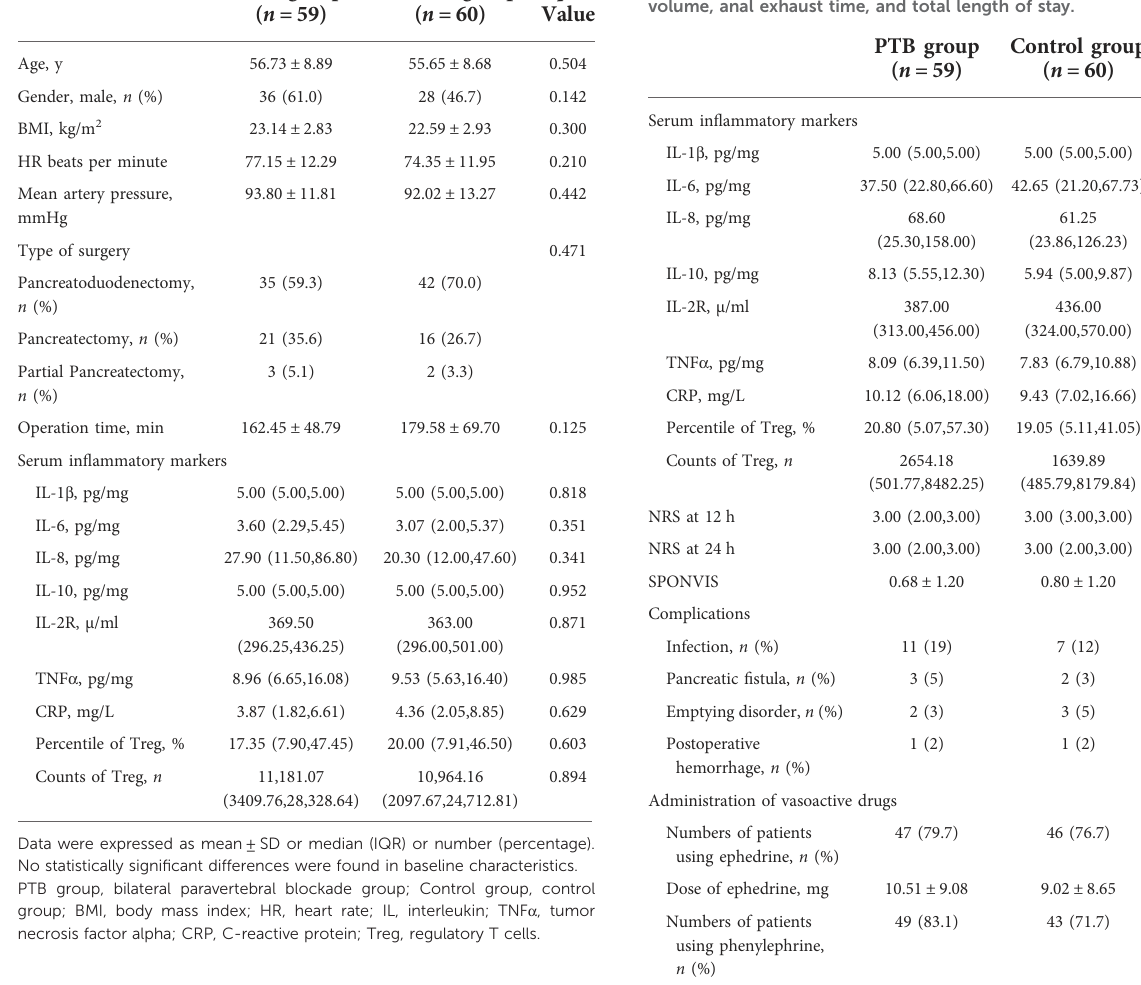
TABLE 1 Demographic and clinical characteristics of participants.